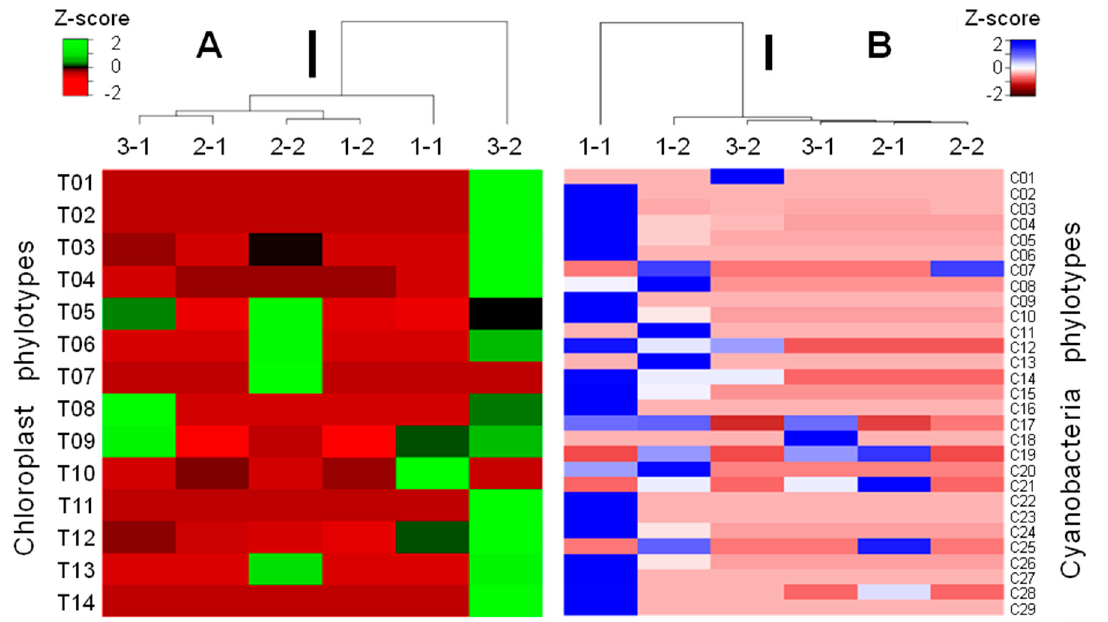
Figure 7. Heatmaps encompassing dendrograms of cluster-analyzed lichen samples based on the phylotype compositions of algae-derived chloroplasts ( A ) and lichen-associated cyanobacteria ( B ). The uniqueness of samples 3-2 and 1-1 is caused by predominant occurrences of specific phylotypes of chloroplast and cyanobacteria, respectively. Phylotype codes correspond to those shown in Table 4. Thick bars beside dendrograms indicate Euclidean distances of the dendrograms as 2000 (A) and 200 (B).